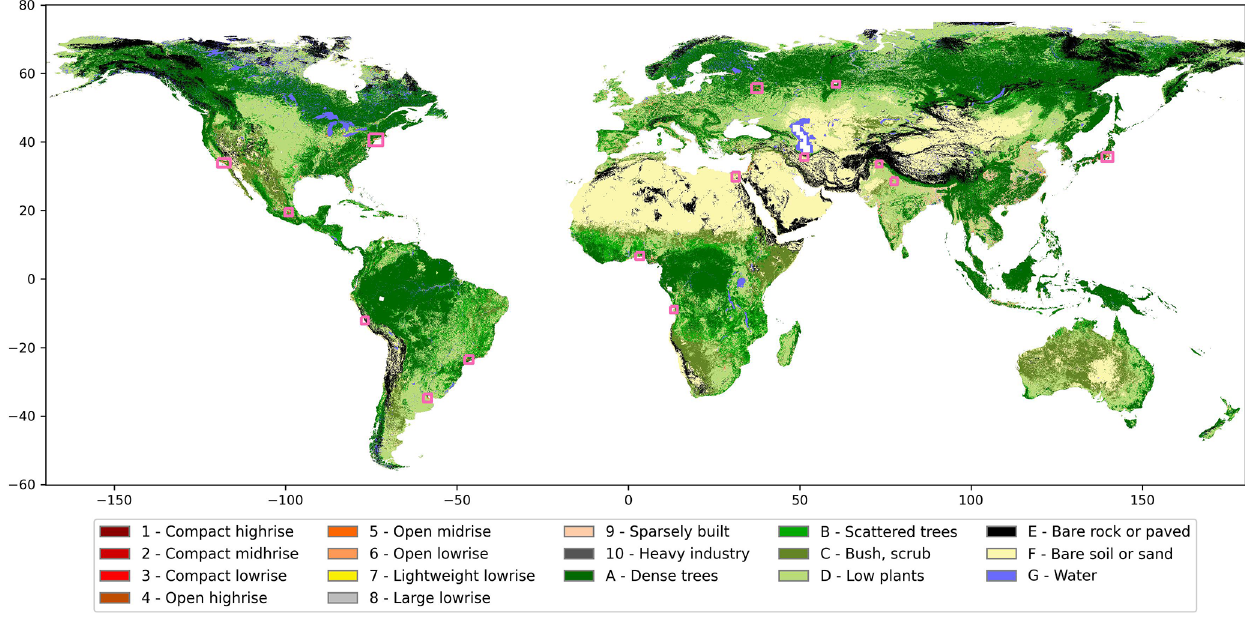
Figure 4. Global map of local climate zones. Detailed views of the pink bounding boxes are shown in Figs. 5, 6, and 7.